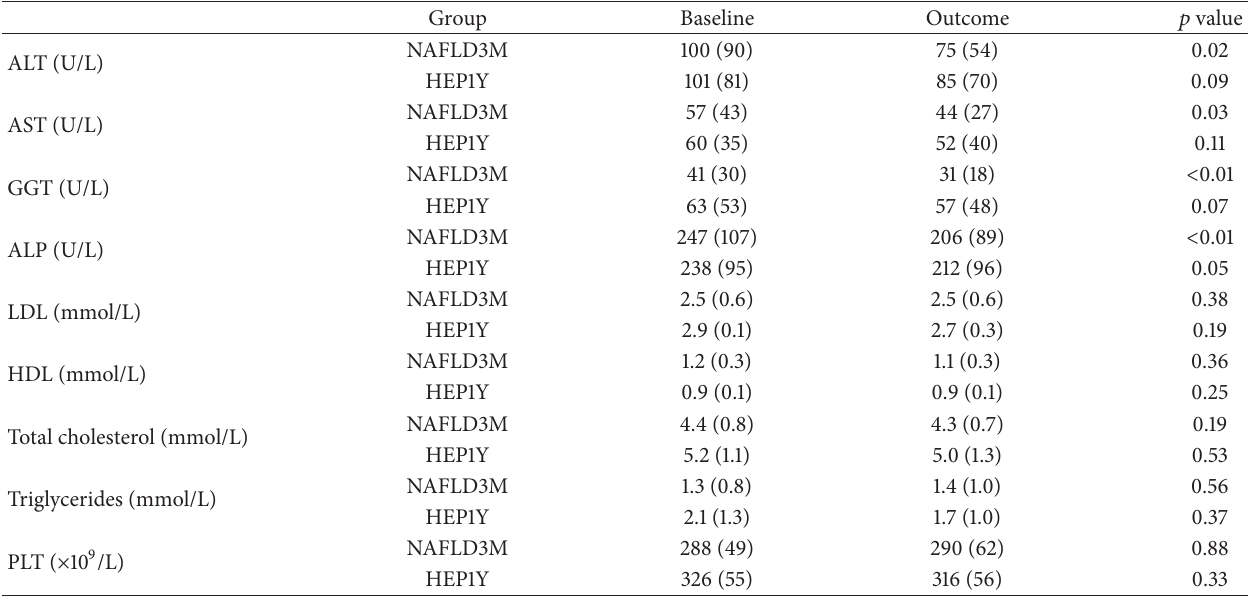
Table 2: Change in laboratory values between baseline and outcome clinic